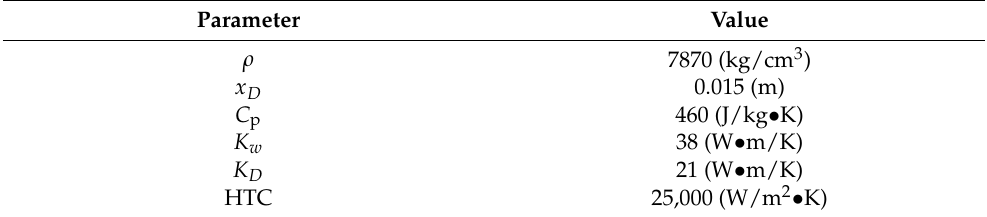
Figure 2. Flow stress curves of 18CrNiMo7-6 alloy steel at different deformation conditions. ( a ) 0.1 s −1 ; ( b )1050 °C; ( c ) 1 s −1 ; ( d ) 5 s −1 . Table 1. Adiabatic correction parameters